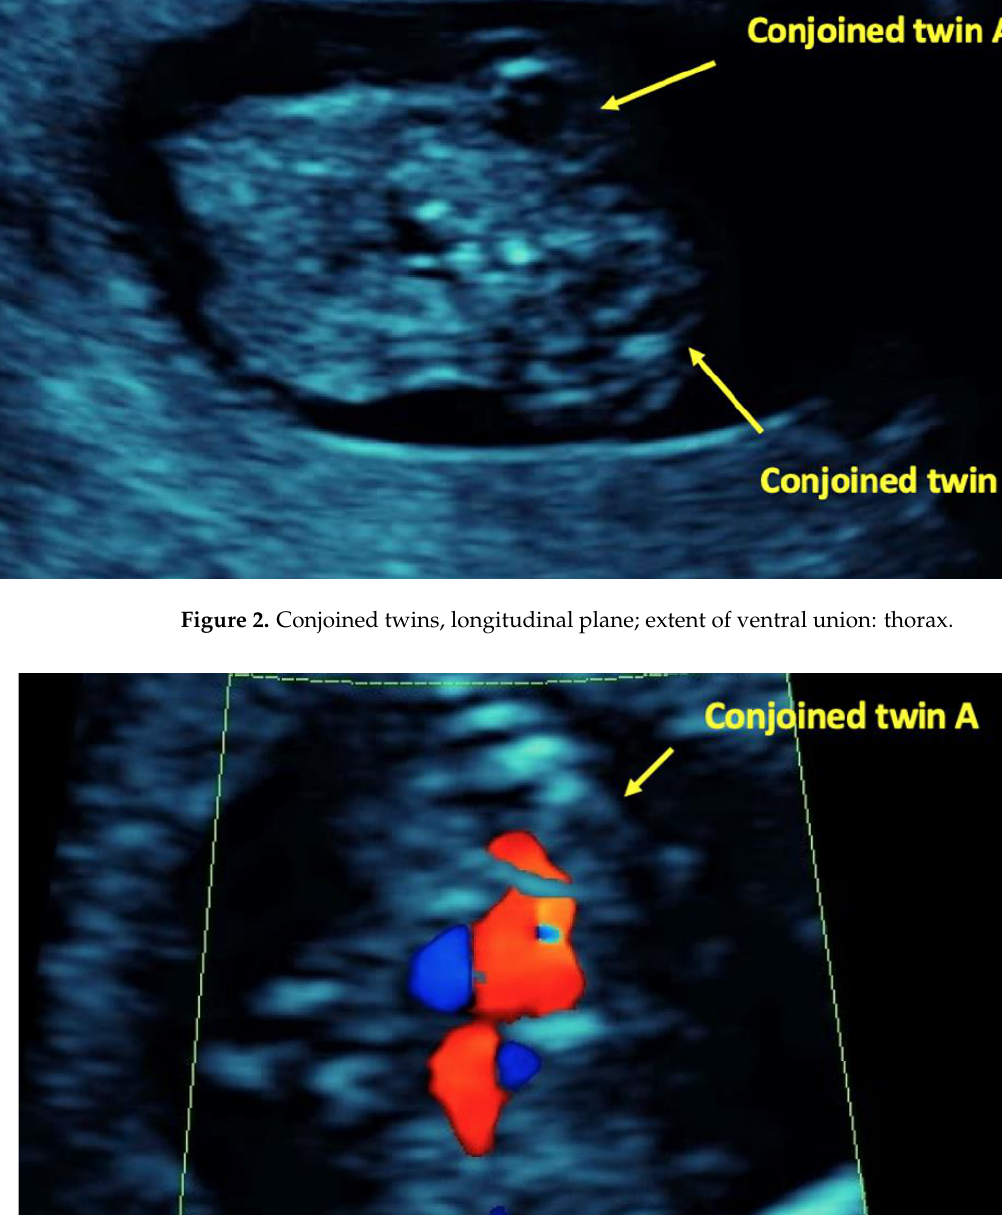
Figure 1. CT in a triplet pregnancy revealed during a 4d ultrasound examination.